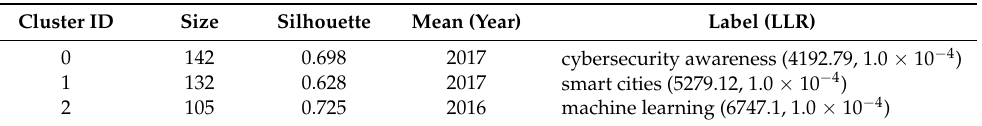
Table 7. Labels and clusters for cybersecurity by keyword